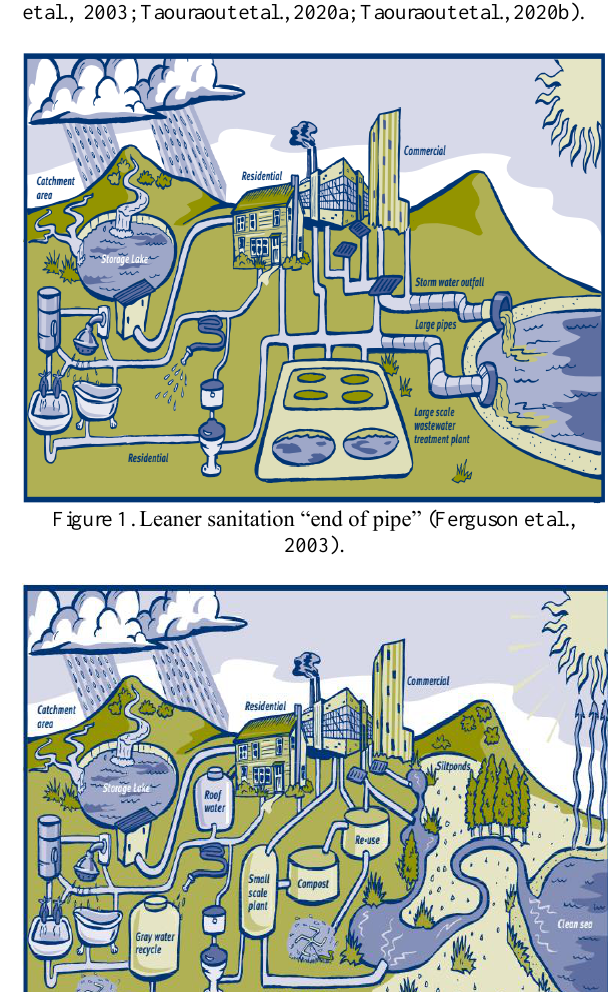
Figure 3 . Schematic representation of Vertical Multi-Soil-